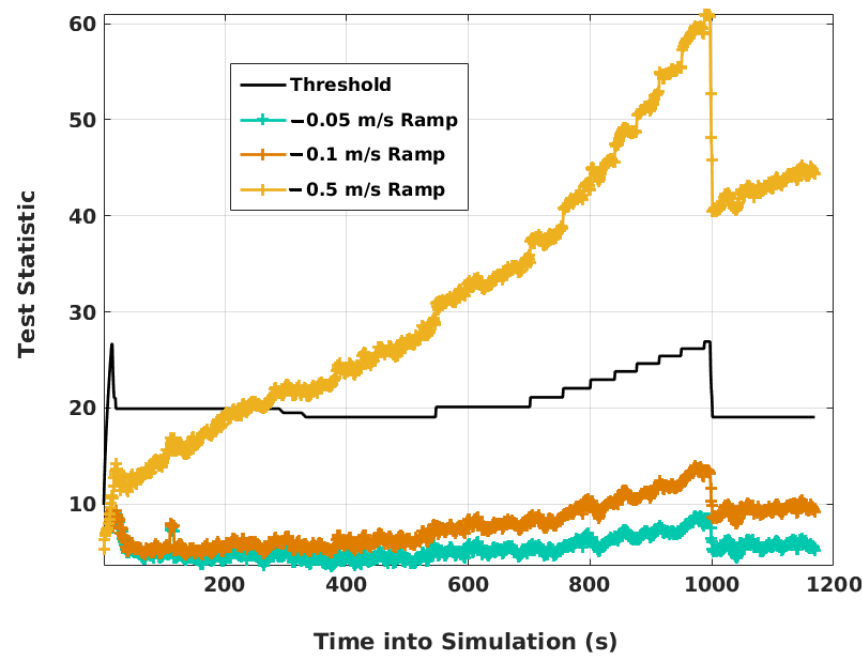
Figure 13. EKF test statistics with different ramp